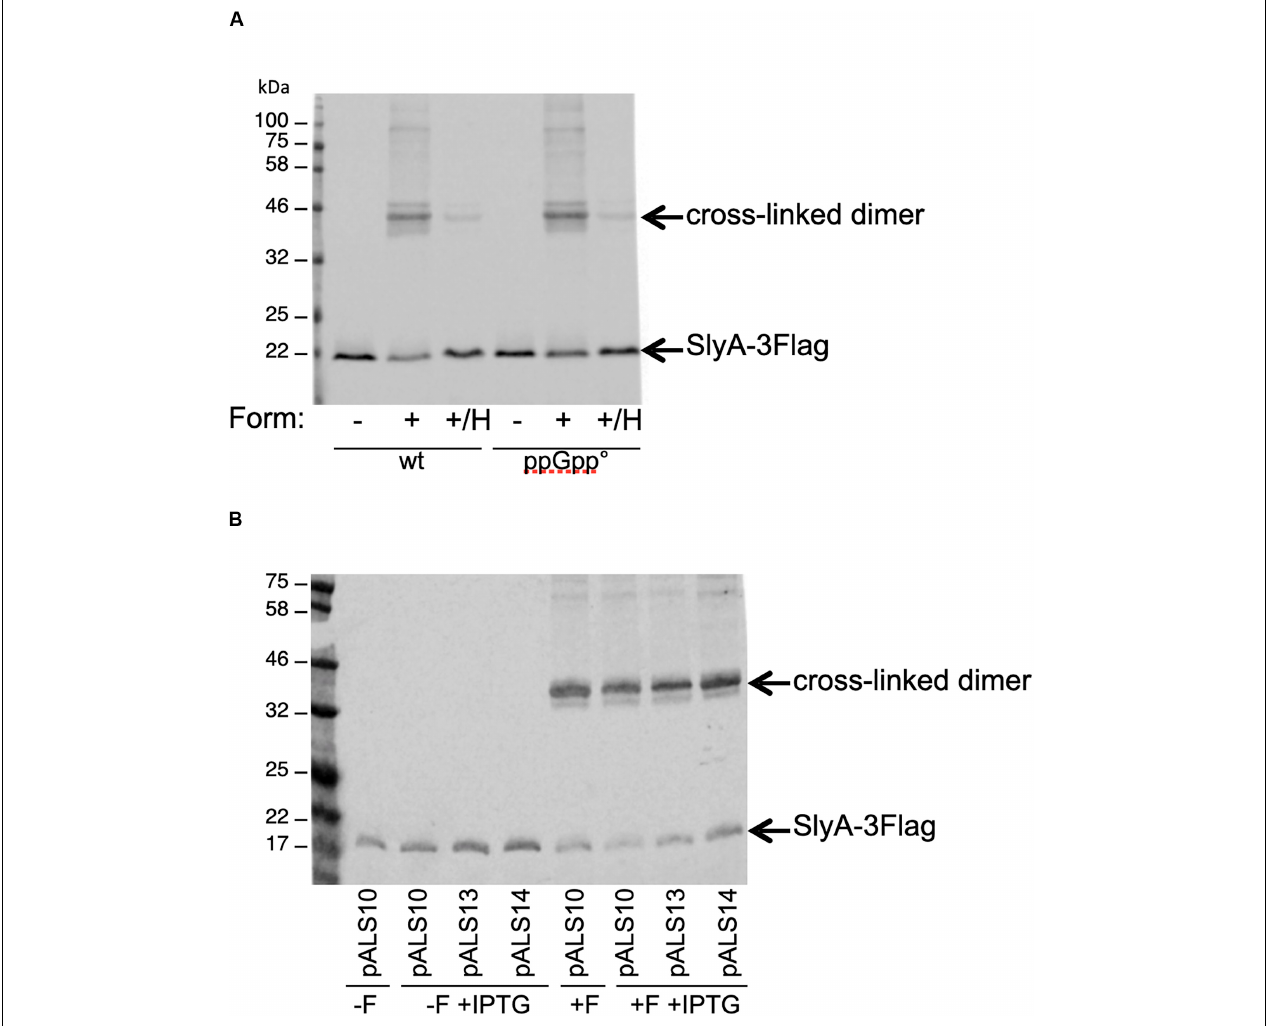
FIGURE 5 | Effect of ppGpp on SlyA dimerization in vivo . (A) MG1655_SlyA-3Flag (EB1106) and ppGpp ◦ _SlyA-3Flag (EB1110) strains were grown to OD600 = 1.3. (B) Strain MG1655_SlyA-3Flag (EB1106) was transformed by plasmids pALS10, pALS13, and pALS14 (pEB0697, pEB0698, and pEB0699, respectively) (Svitil et al., 1993). These transformed strains were grown to OD600 = 1.5 and then relA expression was induced with 1 mM IPTG for 30 min. Then, for both panels, the cells were cross-linked with formaldehyde as described in section “Materials and Methods.” +F, with formaldehyde; –F, without formaldehyde; +/H,